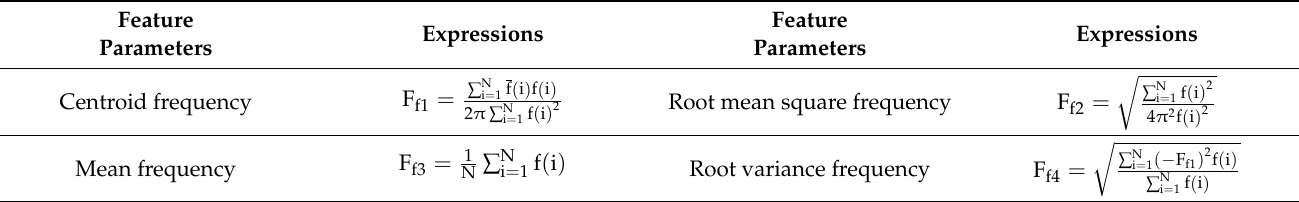
Table 4. Frequency domain feature parameters and their